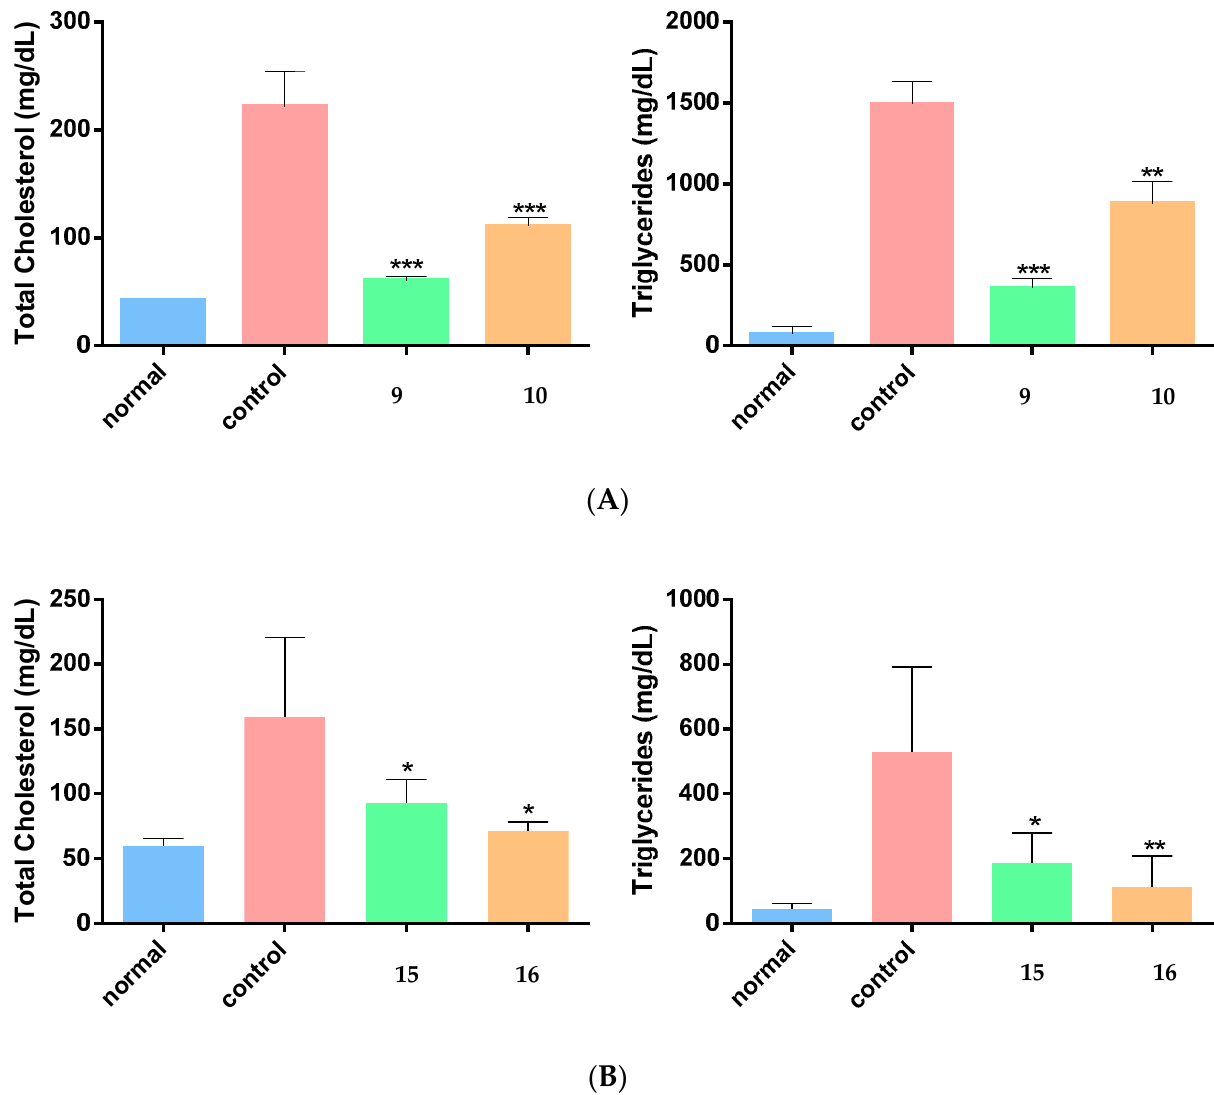
Figure 4. Effect of ( A ) compounds 9 and 10 ; and ( B ) compounds 15 and 16 on total cholesterol and triglyceride levels of experimentally induced hyperlipidemic animals. Significant difference from (tyloxapol-treated) control: * p < 0.02, ** p < 0.002, *** p < 0.0001.